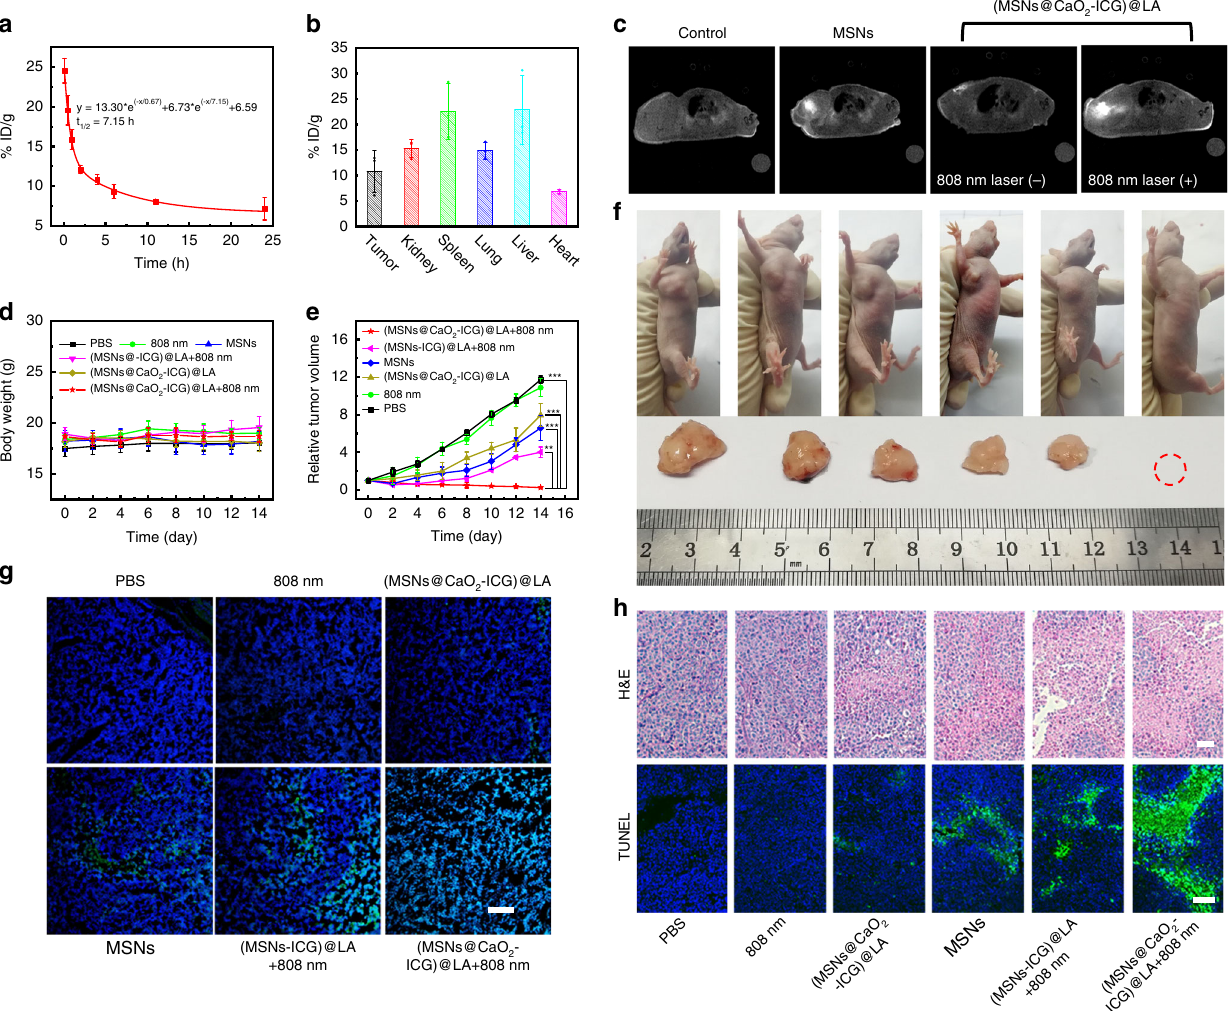
Fig. 5 In vivo demonstration of synergistic CDT/PDT. a Blood circulation and b biodistribution of (MSNs@CaO 2 -ICG)@LA by measuring Mn concentrations over a span of 24 h after intravenous injection. Data are presented as mean ± SD ( n = 3). c In vivo MRI of MCF-7 tumor-bearing mice with different treatments after 24 h (Laser: 808 nm, 0.64 W cm − 2 , 10 min). d The body weight and e the relative cancer volume changes of MCF-7 tumor- bearing mice after various treatments in 14 days. The mean value was calculated by the two-tailed t test (mean ± SD, n = 5). ** P < 0.01 and *** P < 0.001, compared with the indicated group. f Representative photos of the mice with different treatments and corresponding tumor tissues collected from different groups at 14 days. g DCFH (green)- and DAPI (blue)-costained tumor tissues collected from different groups at 24 h post injection. Scale bar: 200 μ m. h H&E- or TUNEL-stained tumor slices collected from different groups at 14 days. Scale bar: 100 μ